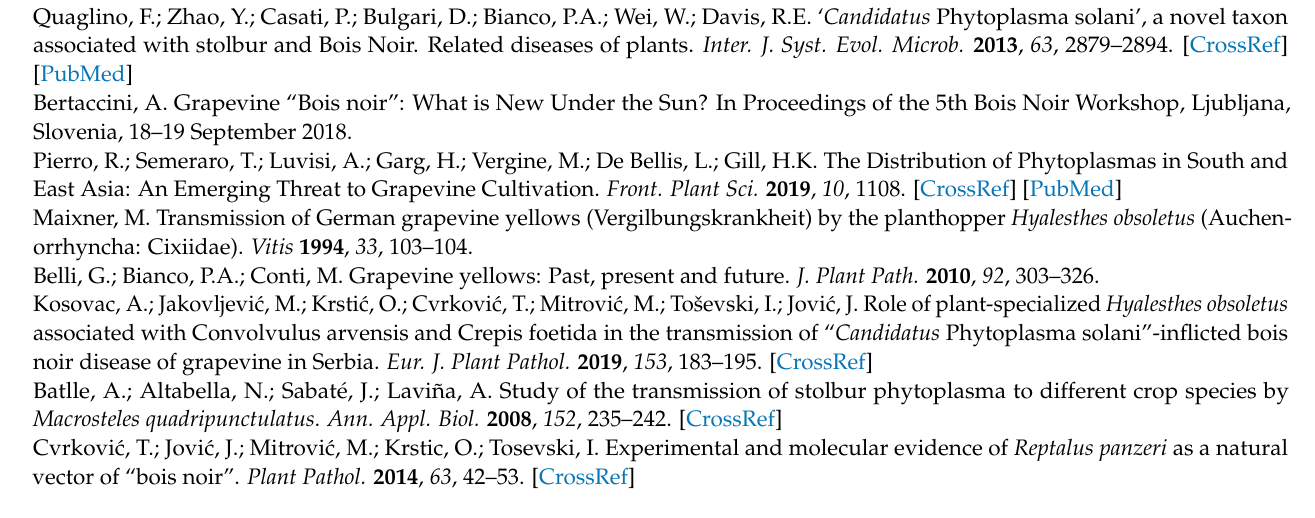
(E). Table S1: Sequence variants Dataset of the gene secY among ‘ Ca . P. solani’ strains available in GenBank. Table S2: Sequence variants Dataset of the preotein SecY among ‘ Ca . P. solani’ strains available in GenBank. Table S3. Sequence identity of SecY variants with templates in Protein Data Bank (PDB). Table S4. Top 10 threading templates used by